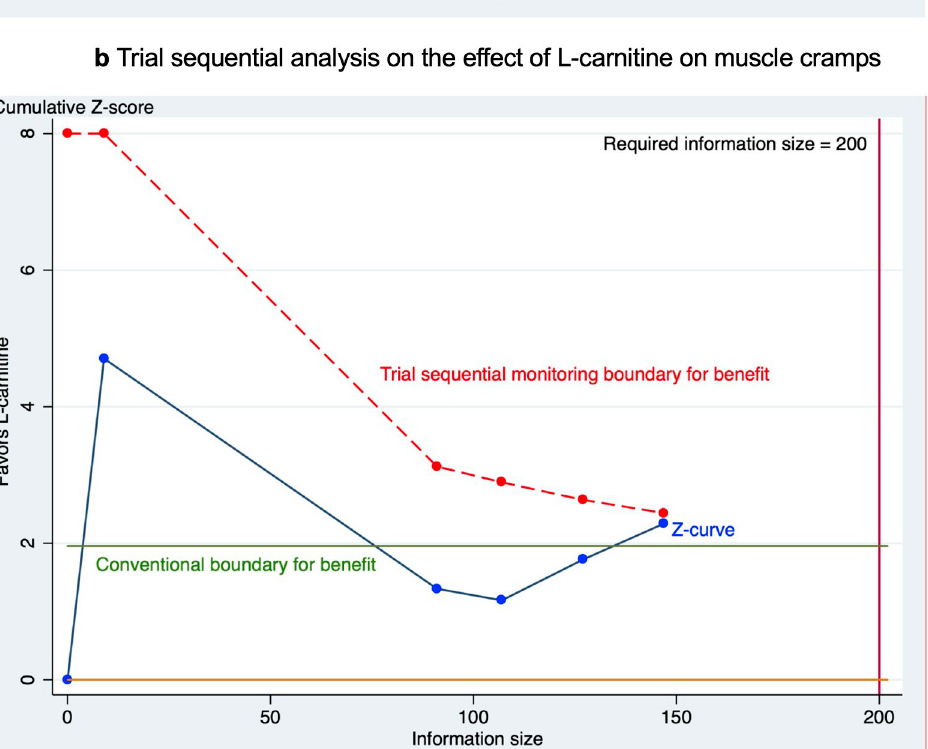
PLOS ONE | https://doi.org/10.1371/journal.pone.0271307 July 14,